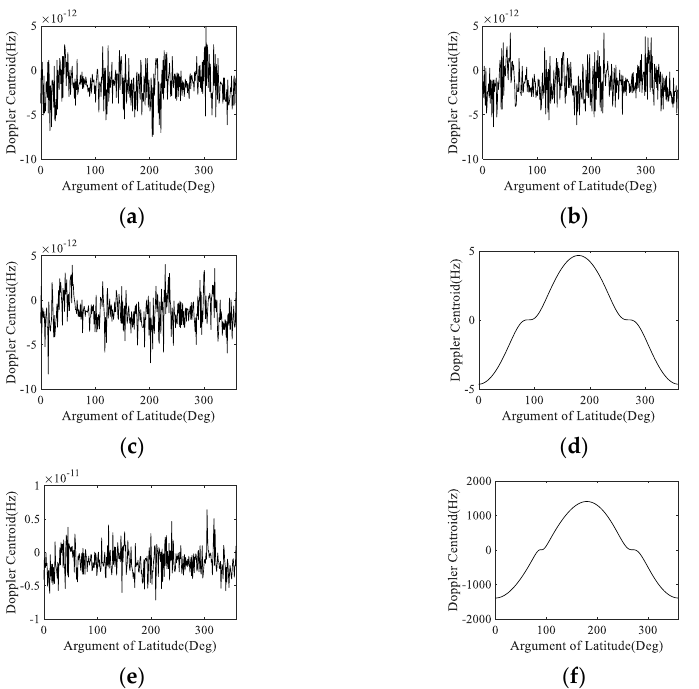
Figure 5. Doppler centroid along the orbit at different eccentricities. ( a , c , e ) consider the variation of the RLS, and the eccentricity is 10 − 8 , 0.01, and 0.1, respectively. ( b , d , f ) without considering the variation of the RLS compared to ( a , c , e ).